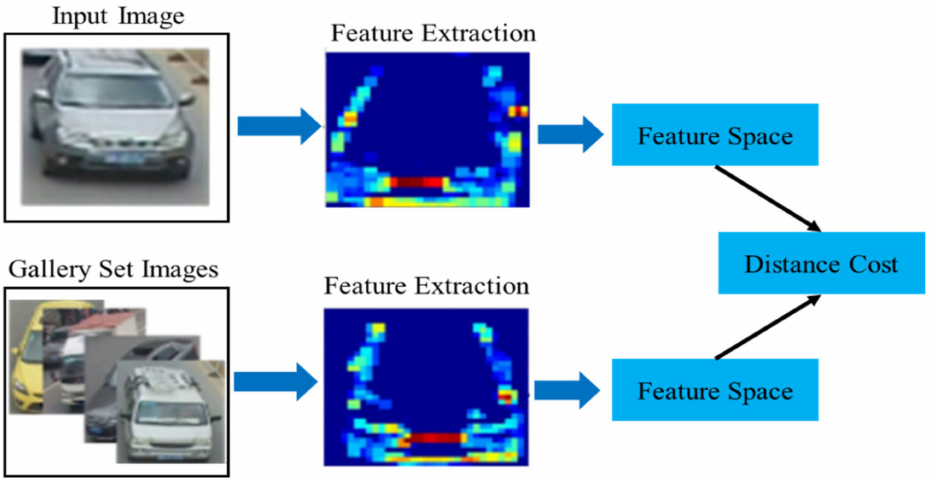
Figure 10. Vehicle re-id system based on metric-based